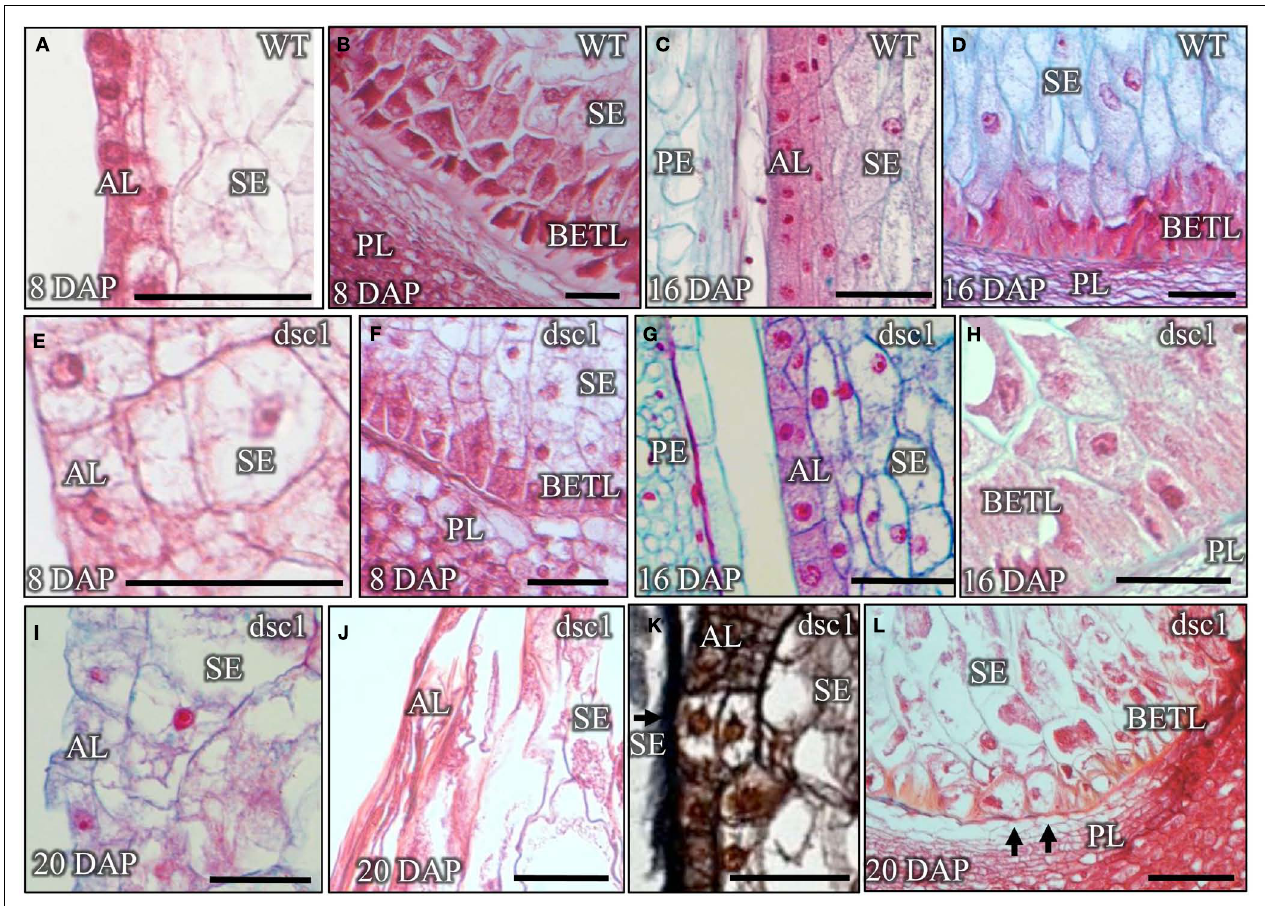
The arrow points to undifferentiated cells in the aleurone cell layer in this kernel harvested 20 DAP. (L) The arrows point to misshapen basal endosperm transfer layer cells that lack cell wall ingrowths at the base of this 20 DAP kernel. All sections were stained with Safranin-0 and Fast Green for the exception of (K) , which is stained with Safranin-O and Orange G. AL, aleurone; BETL, basal endosperm transfer layer; DAP, days after pollination; PE, pericarp; PL, placenta; SE, starchy endosperm. Scale bars represent 100 μ